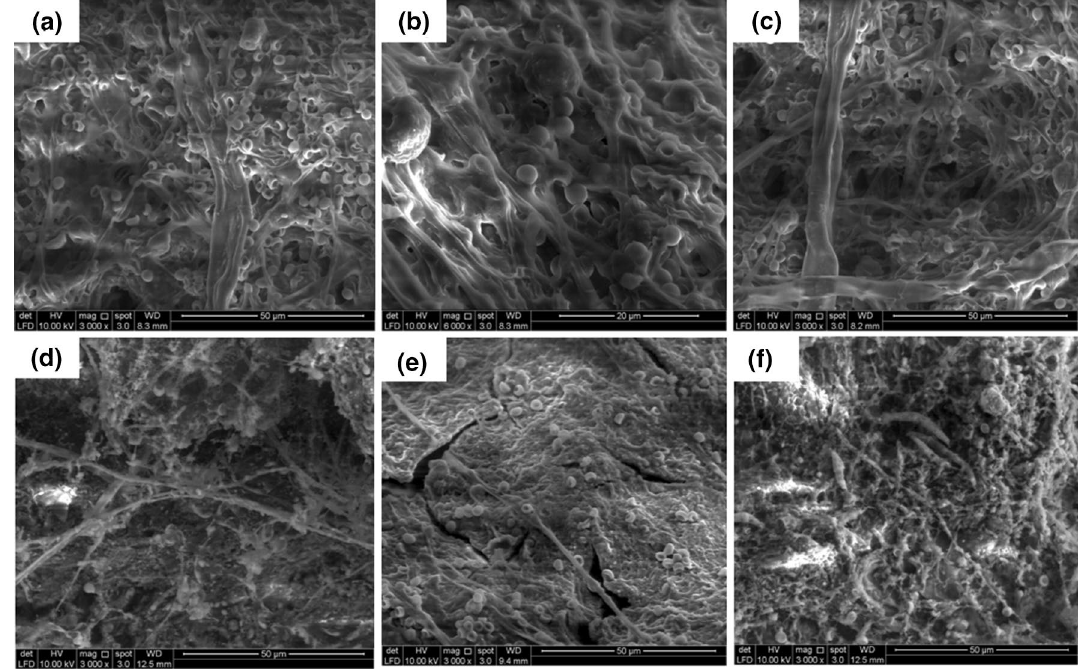
Fig. 7 SEM images of (a, d) GO-anode Vs graphite-cathode (b, e) GO-ZnO anode Vs graphite cathode (c, f) GO-TiO